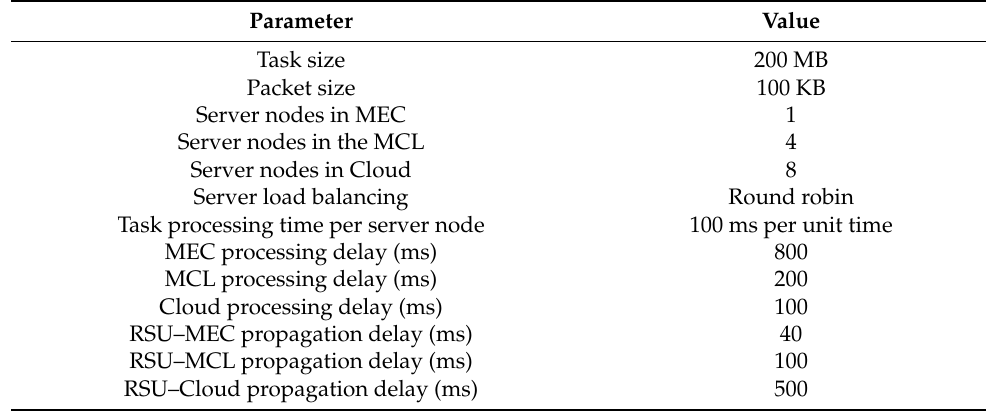
Table 5. Settings of implementation-based simulation for our comparison scenario; ms = milliseconds, KB = kilobytes, MB =